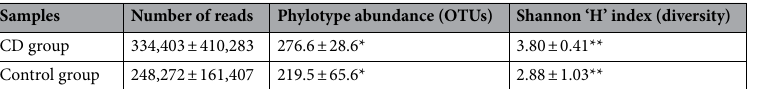
Table 2. Average number (± SD) of sequences, phylotype abundance (OTUs) and Shannon ‘H’ diversity index in the samples analyzed ( * p = 0.016; ** p = 0.008).